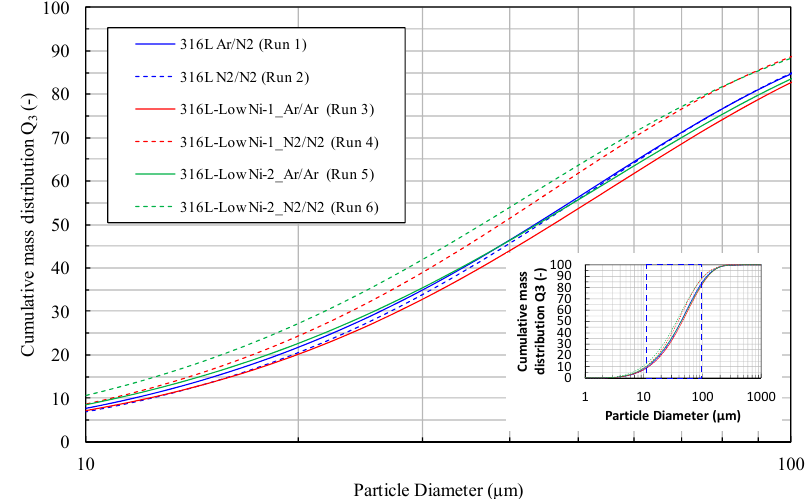
Figure 3. Particle size distributions of the gas atomized 316L and modified 316L powders. The nomenclature used in the diagram, for instance Ar / N2, indicates that the first element corresponds to the melting atmosphere and the second to the atomization gas.